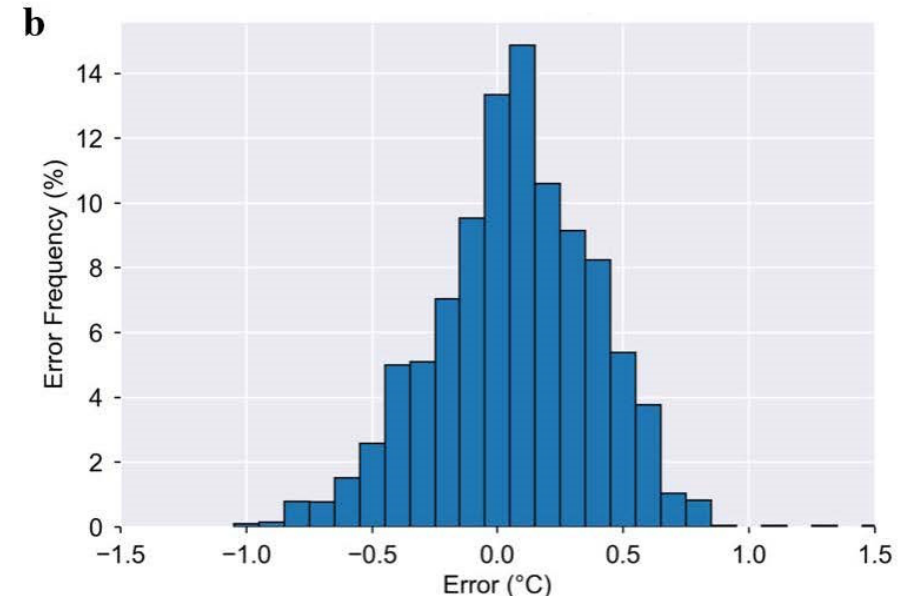
Figure 2. Kenzen T C algorithm performance vs. ground truth T C . ( a ) Correlation between ground truth and Kenzen T C for all 52 trials (4036 min of data; r = 0.94, p < 0.001). Dotted line represents a correlation of 1.0, showing that the Kenzen algorithm tends to slightly overestimate T C at higher core temperatures. ( b ) Histogram showing the mean error distribution for all data based on one-minute averages of Kenzen T C minus ground truth T C (rounded to one decimal place). ~70% of data had an MAE ≤ 0.30 ◦ C, the pre-established accuracy criteria. The histogram also shows that the Kenzen T C tends to slightly overestimate (vs. underestimate) ground truth T C to protect workers from heat-related injuries and